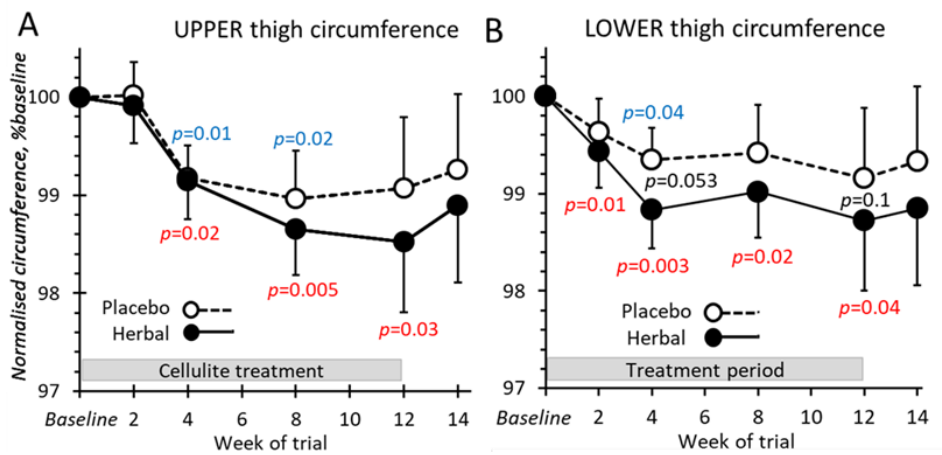
Figure 5. Thigh circumferences 20 (upper) ( A ) or 10 cm (lower) ( B ) above the knee treated with either placebo or herbal emgels. The measurements expressed as the corresponding ratio at time 0 (baseline). For the upper thighs, actual baseline values for placebo and herbal emgels were 55.4 ± 1.1 and 55.6 ± 1.1 cm respectively and 47.1 ± 0.9 and 47.6 ± 1.0 cm for the lower thighs. p -value color coded as Figure 4.